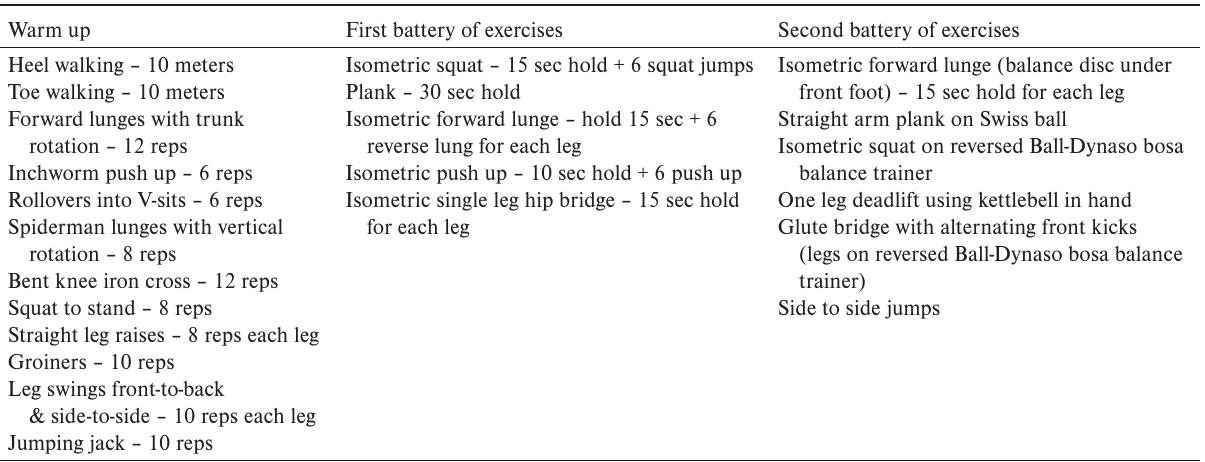
Warm up and batteries of exercises Warm up First battery of exercises Second battery of